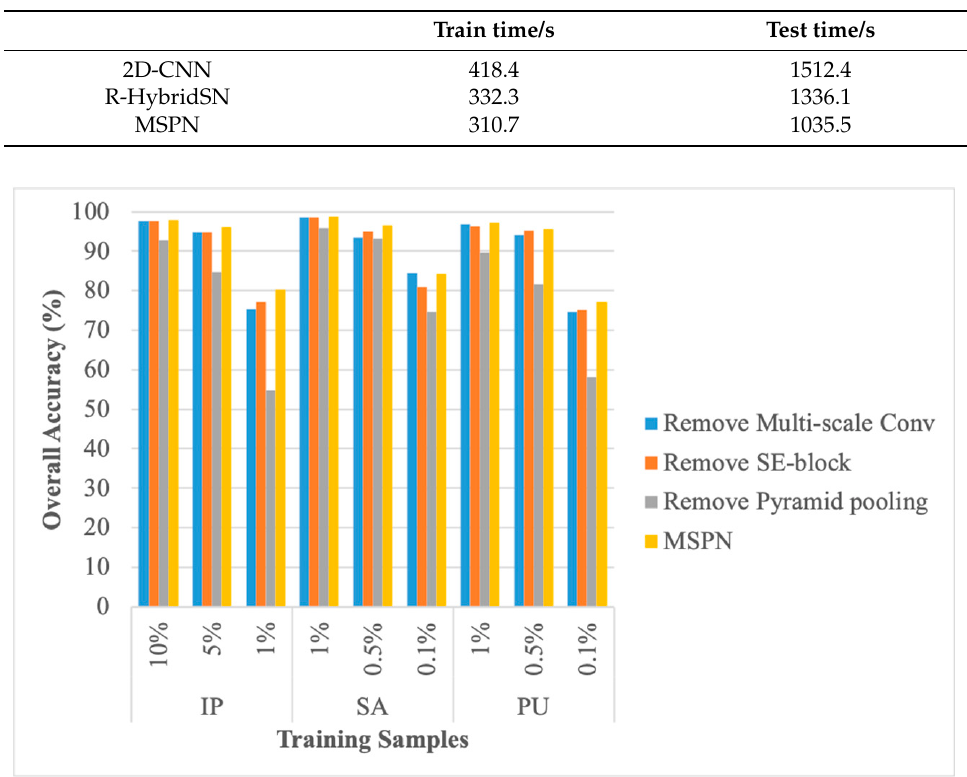
Table 5. Speed comparison of different methods in the Pavia University dataset with 0.5% training samples (processor: 1.8 GHz Intel Core i5, no GPU acceleration).